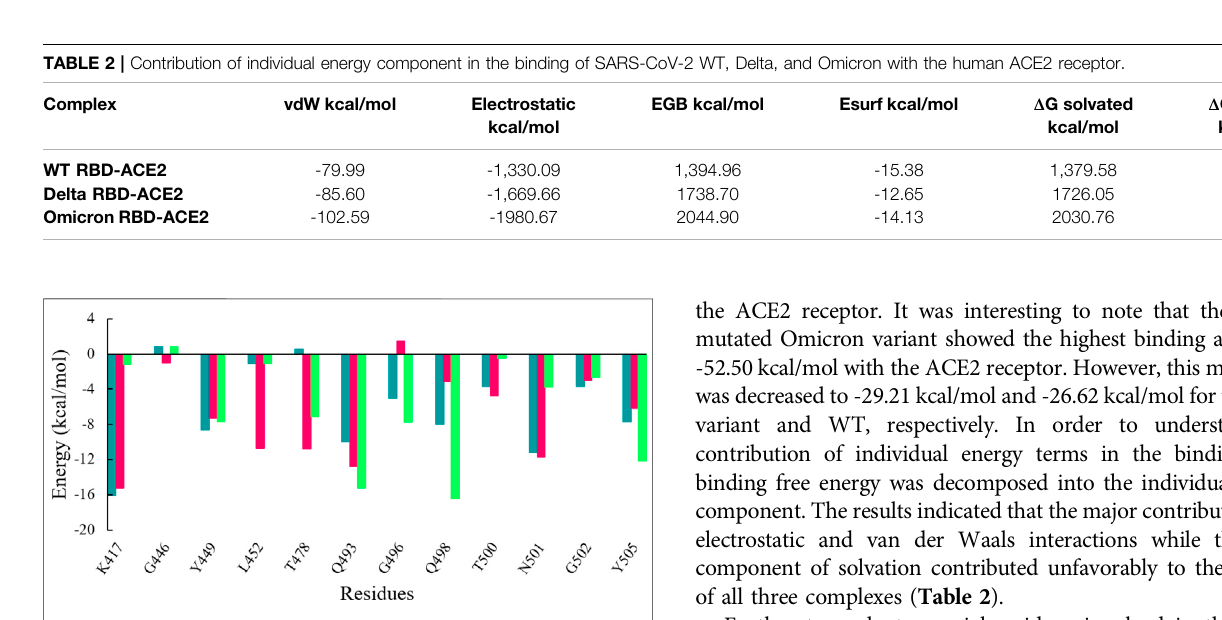
FIGURE8| Energycontribution ofinterfacialresiduesofRBDofWT(sea green), Delta (violet red), and Omicron variants (lime green).